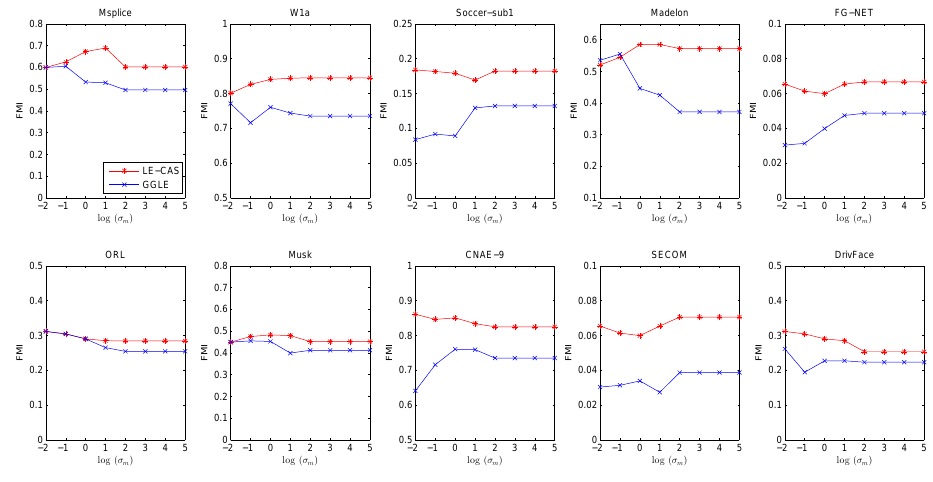
Figure 6. Results (FMI) vs. σ m on ten datasets (Msplice, W1a, Soccer-sub1, Medelon, FG-NET, ORL, Musk, CNAE-9, SECOM,